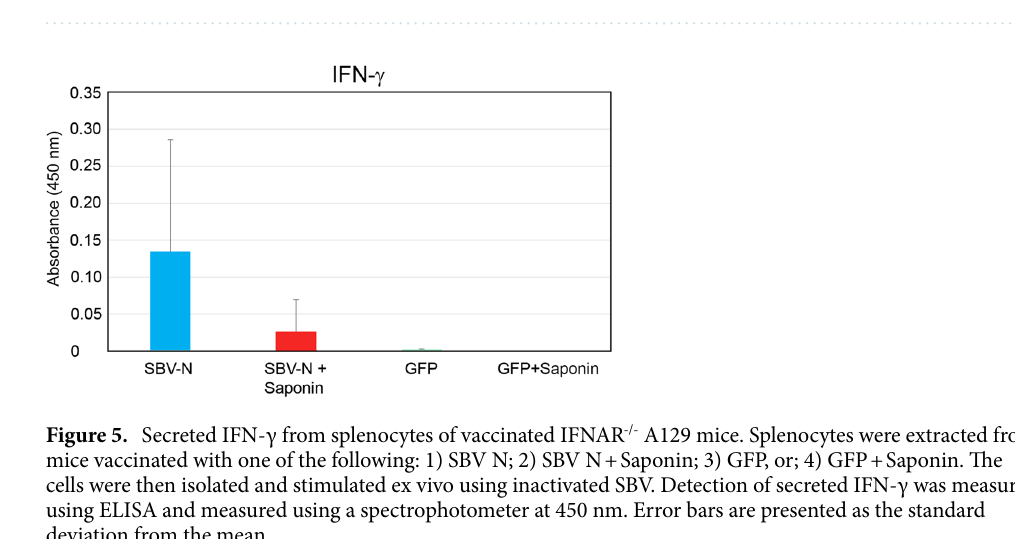
Figure 4. Cellular proliferation of splenocytes from vaccinated IFNAR -/- A129 mice. Splenocytes were extracted from mice vaccinated with one of the following: 1) SBV N; 2) SBV N + Saponin; 3) GFP, or; 4) GFP + Saponin. Splenocytes from each mouse were then incubated with CFSE (see “Materials and methods” section) and stimulated with inactivated SBV for 3 days. The cells were then fixed and incubated with either CD4 ( a ) or CD8-specifc ( b ) antibodies and the proliferation index (average number of divisions of just the responding cells) quantified by flow cytometry. The cell proliferation index is presented as the value of stimulated splenocytes (i.e. in the presence of antigen) minus that of splenocytes under non-stimulating conditions. Error bars are presented as the standard deviation from the mean.